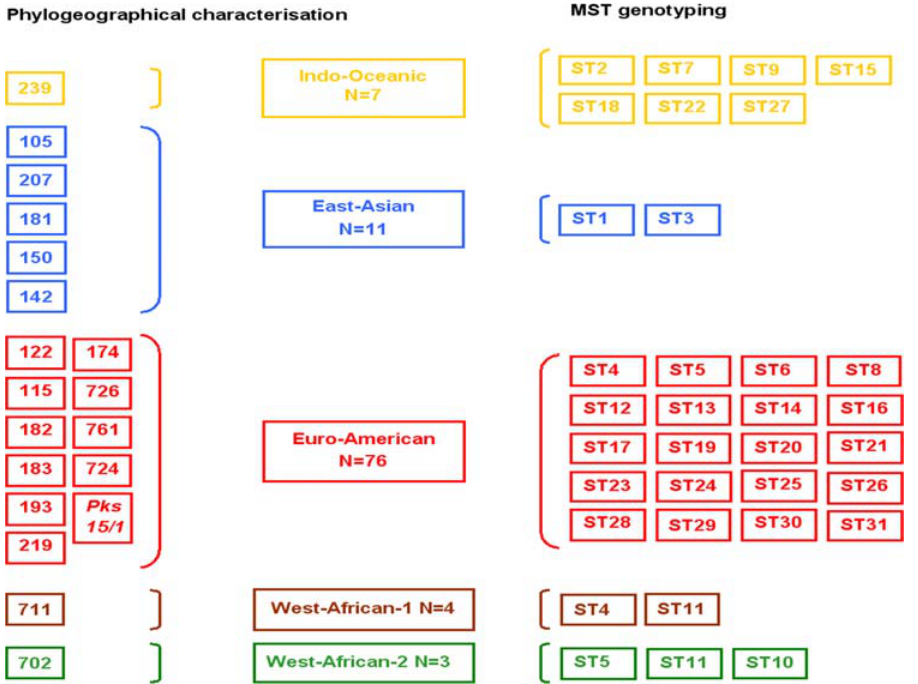
Figure 1. Comparison of the distribution of 101 M.tuberculosis into five phylogeographical lineages and MST profiles defined in present study. From left to right, large polymorphism sequences, phylogeographical lineages defined by Gagneux et al [13], spacer types obtained by MST. doi:10.1371/journal.pone.0002433.g001 PLoS ONE |